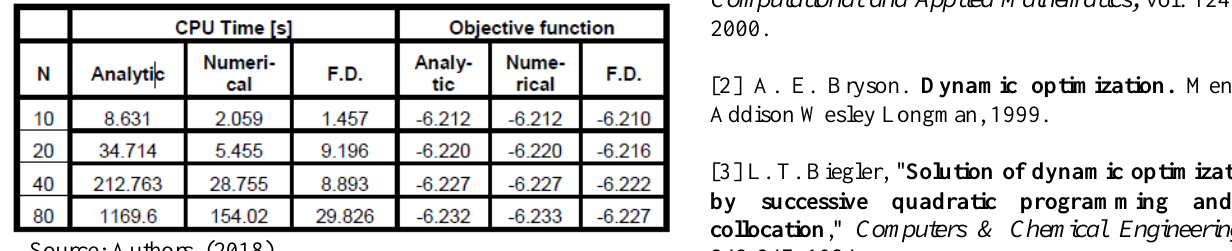
Table III: CPU Time and objective function